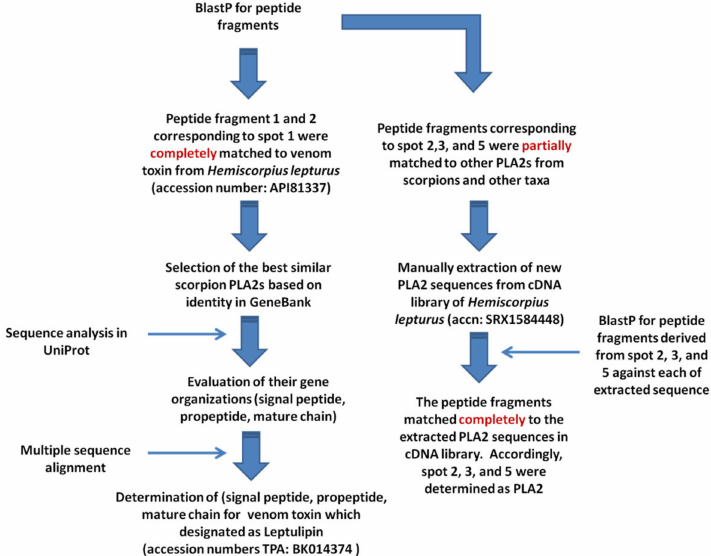
Figure 3. Two-dimensional gel electrophoresis of the HPLC-derived-fraction, F3. Five identical spots were selected and partial sequencing was performed. The numbers 1–5 refer to the identical protein